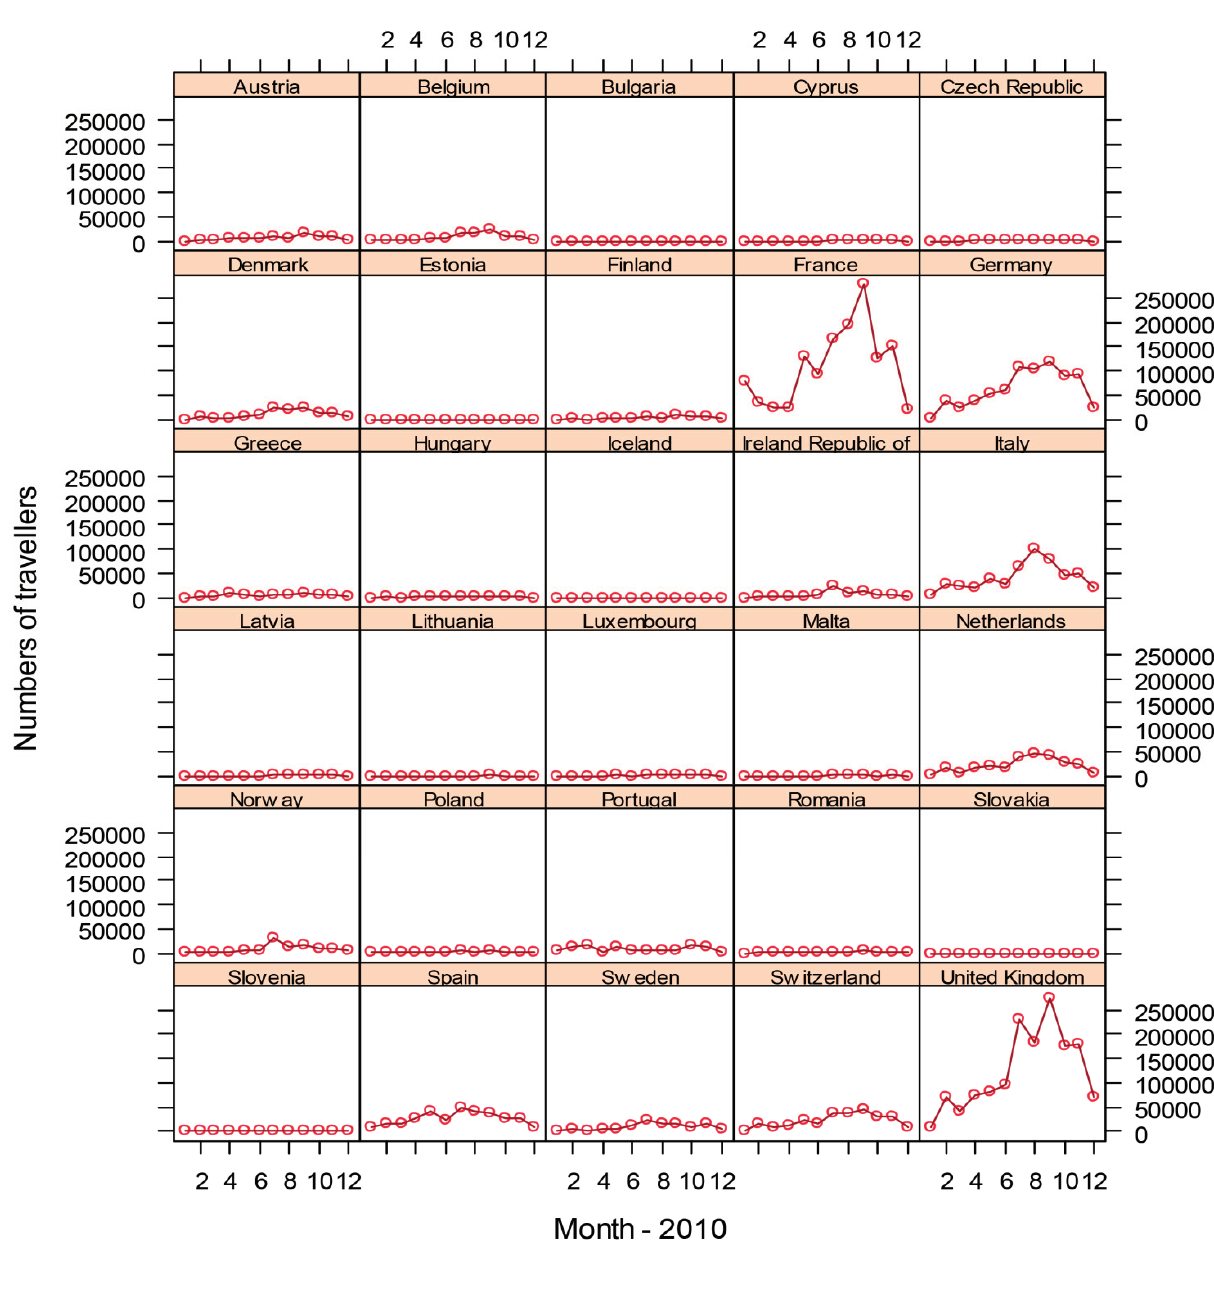
Figure 7. Country-level destination of international air travellers from dengue affected areas, by month 2010. Reprinted with permission from